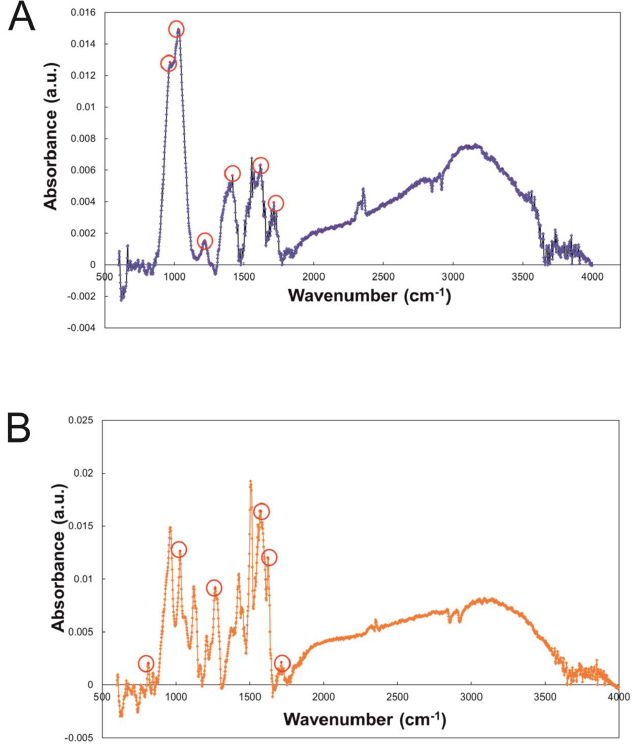
Figure 2. ( A ) FTIR spectroscopy of GO and ( B ) GO/CU with characteristic peaks highlighted. The material was directly laid on the ATR crystal, and the spectra were recorded.